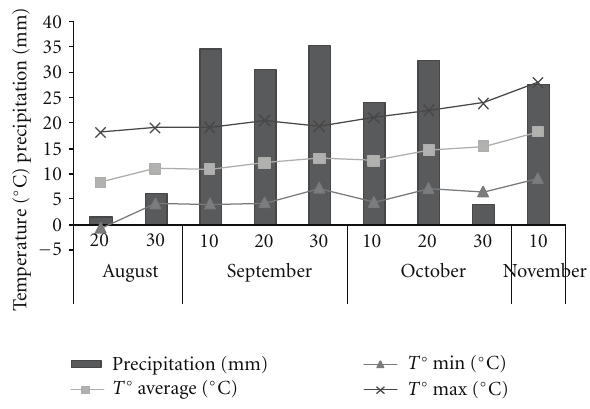
Table 8: Incidence (%) of tan spot (DTR) in various phenological states for total irrigation (TI), irrigation with controlled deficit (CDI), and dry (D)